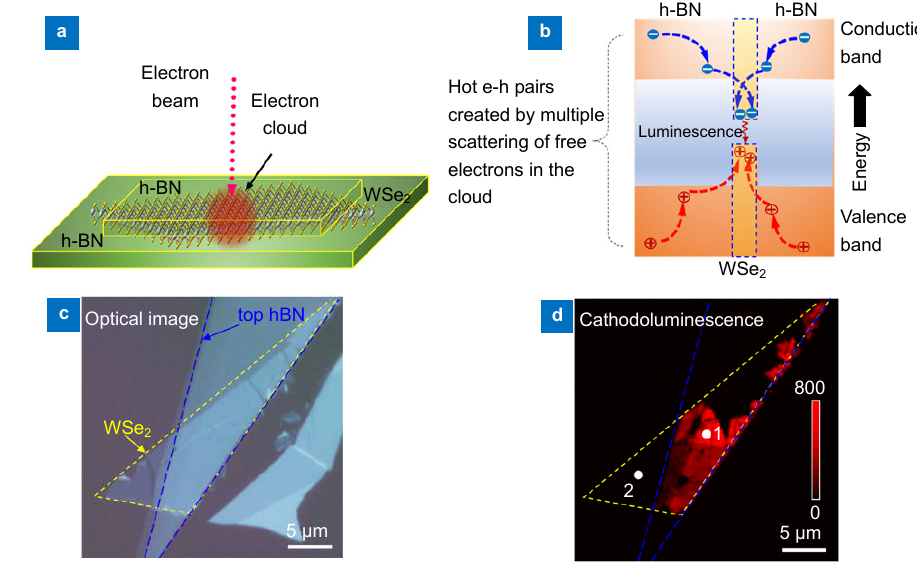
Fig. 6 | ( a ) Schematic of hBN/WSe 2 /hBN van der waals heterojunction excited by electron beam. ( b ) Process of the generation, diffusion, and recombination of electron − hole (e-h) pairs in heterojunction. ( c ) Optical microscope image of a hBN/ WSe 2 /hBN heterostructure. ( d ) Monochromatic CL image of the heterostructure at WSe 2 emission energy (1.66 eV). Figure reproduced from ref. 67 , ACS